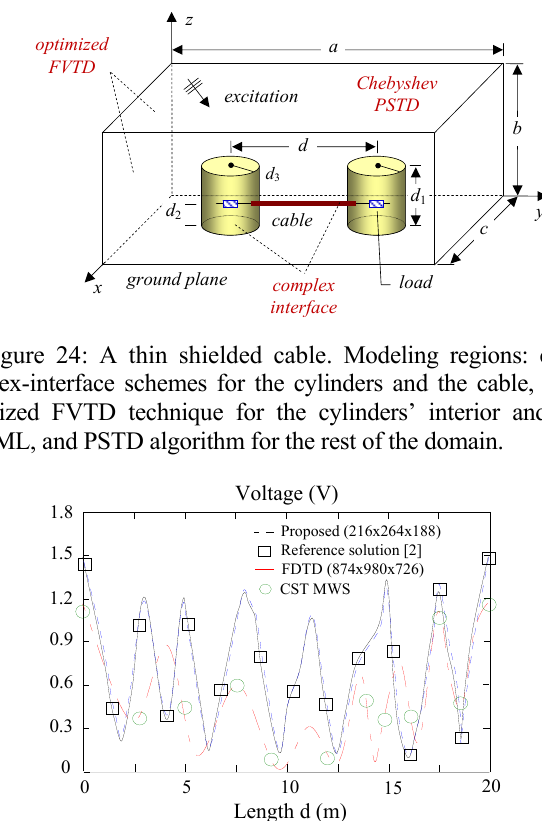
component z Figure 25: Voltage at the cable as a function of its length. with a resolution of λ /50 comprises 874  980  726 ≈ 621.8 million cells and 22.23 GB RAM, unlike that of our hybrid method which needs only 216  264  188 ≈ 10.7 million cells